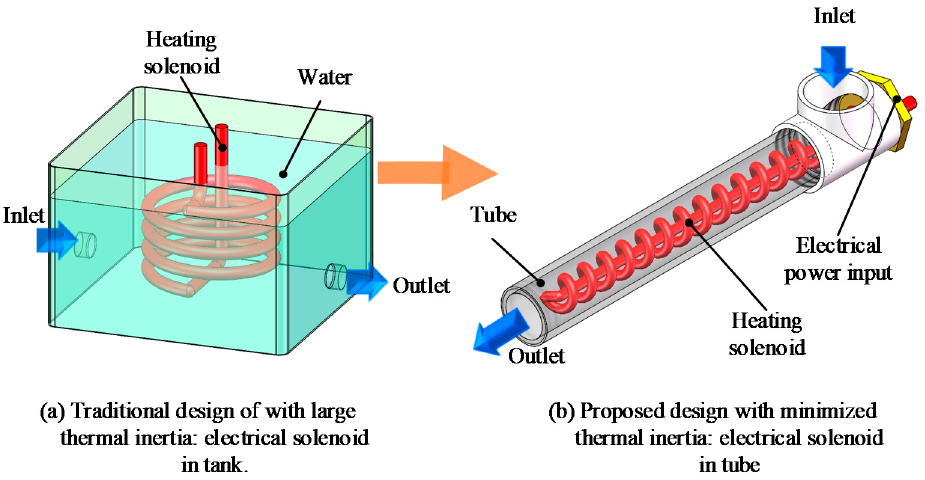
Figure 7. Scheme of the tube heating module.